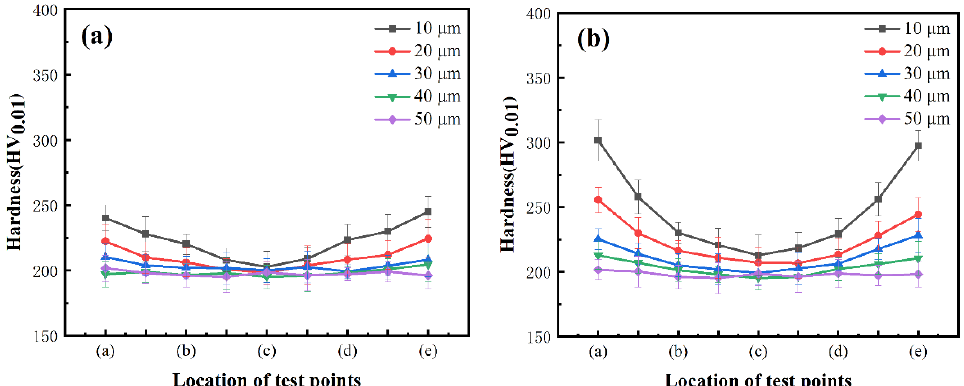
Figure 11. Microhardness changes in different areas of 40Cr pin wear surface and different depths below the surface under reciprocating sliding duration of: ( a ) 15 min; ( b ) 120 min; the abscissa represents each area in Figure 8f.